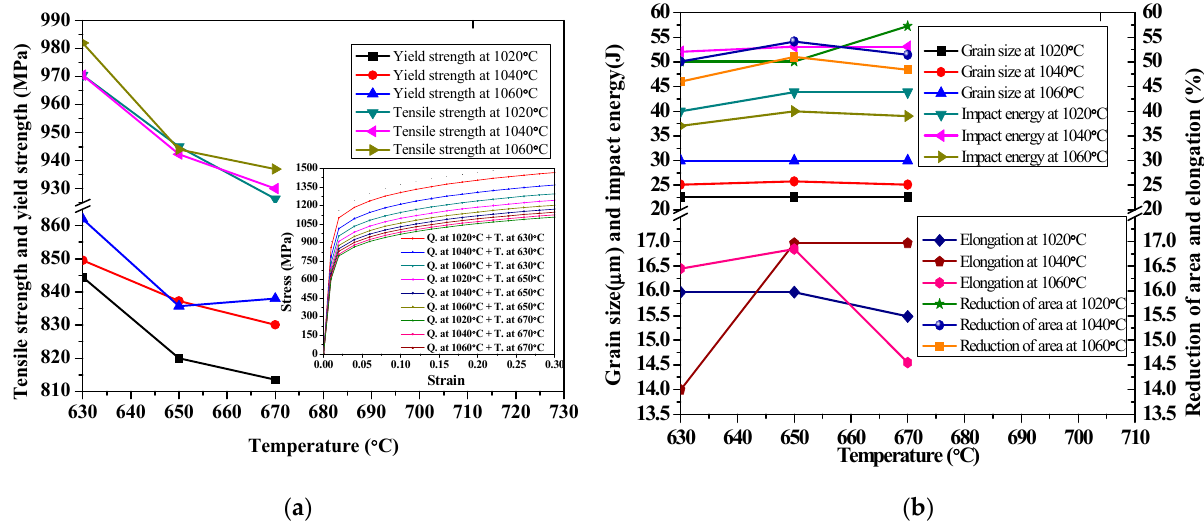
Figure 12. Measured mechanical properties: ( a ) tensile and yield strengths; ( b ) grain size, impact energy, reduction of area and elongation.